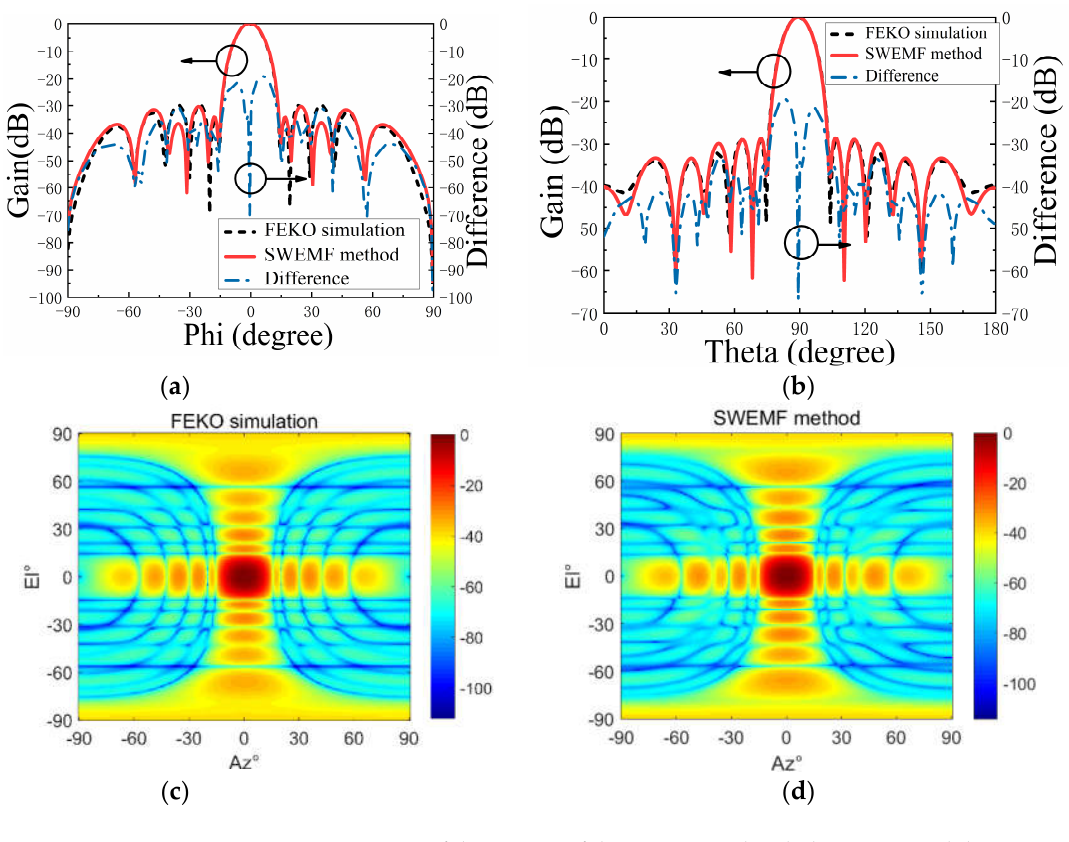
Figure 7. Comparison of the pattern of the FEKO simulated plane array and the pattern obtained by the SWEMF method. ( a ) Theta = 90° surface, ( b ) Phi = 0° surface, ( c ) pattern simulated by FEKO and ( d ) pattern calculated by the SWEMF method.